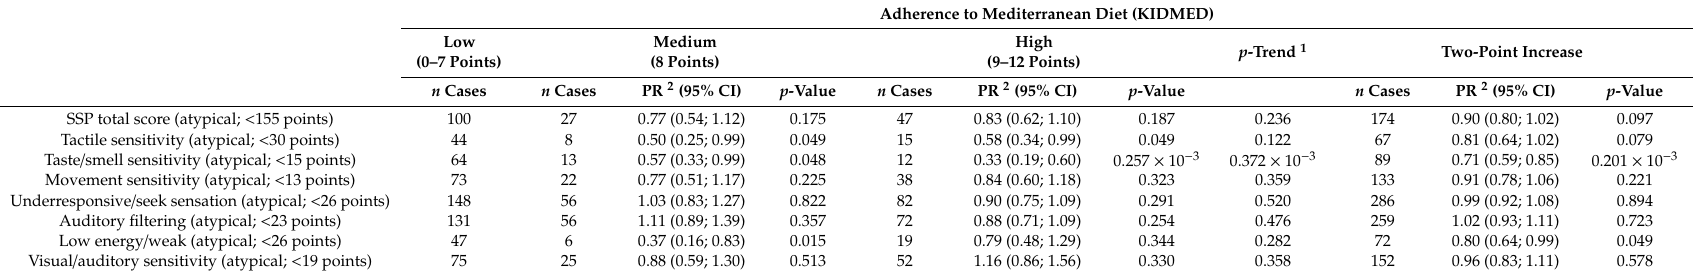
Table 2. Association between adherence to the Mediterranean diet (MD) and prevalence of atypical sensory processing using total and subscales scores of short sensory profile (SSP) in children aged 3–7 years from InProS Project, Alicante, Spain ( n =